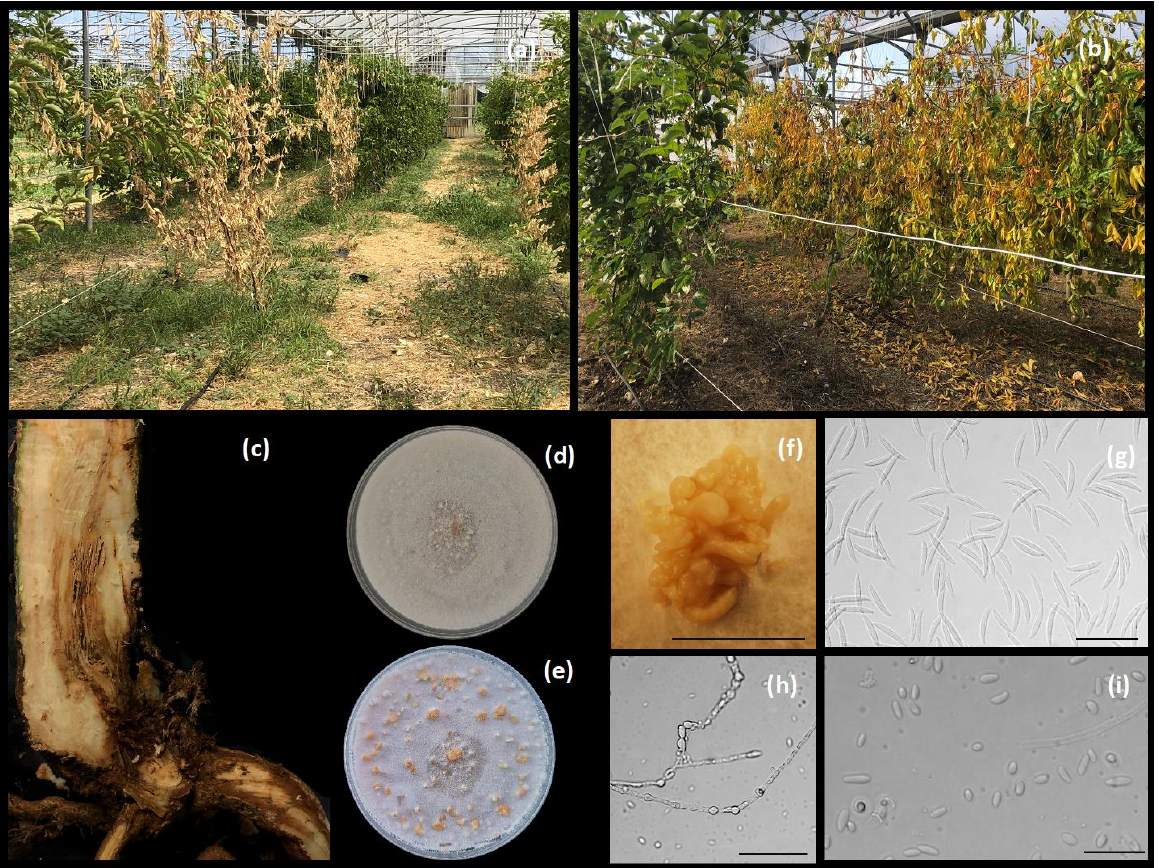
Figure 1. Disease symptoms and Fusarium nirenbergiae features: ( a , b ), yellowing and wilting of passion fruit plants in greenhouse; ( c ), vascular discoloration on a collar portion; ( d , e ), F. nirenbergiae (Di3A-Pef1 isolate) grown on 7 day-old (up) and 14 day-old (down) OA; ( f ), sporodochia on OA; ( g ), sporodochial conidia (macroconidia); ( h ), chlamydospores on SNA; ( i ), aerial conidia (microconidia). Scale bars, ( f ): 2 mm; ( g – i ): 50 µ